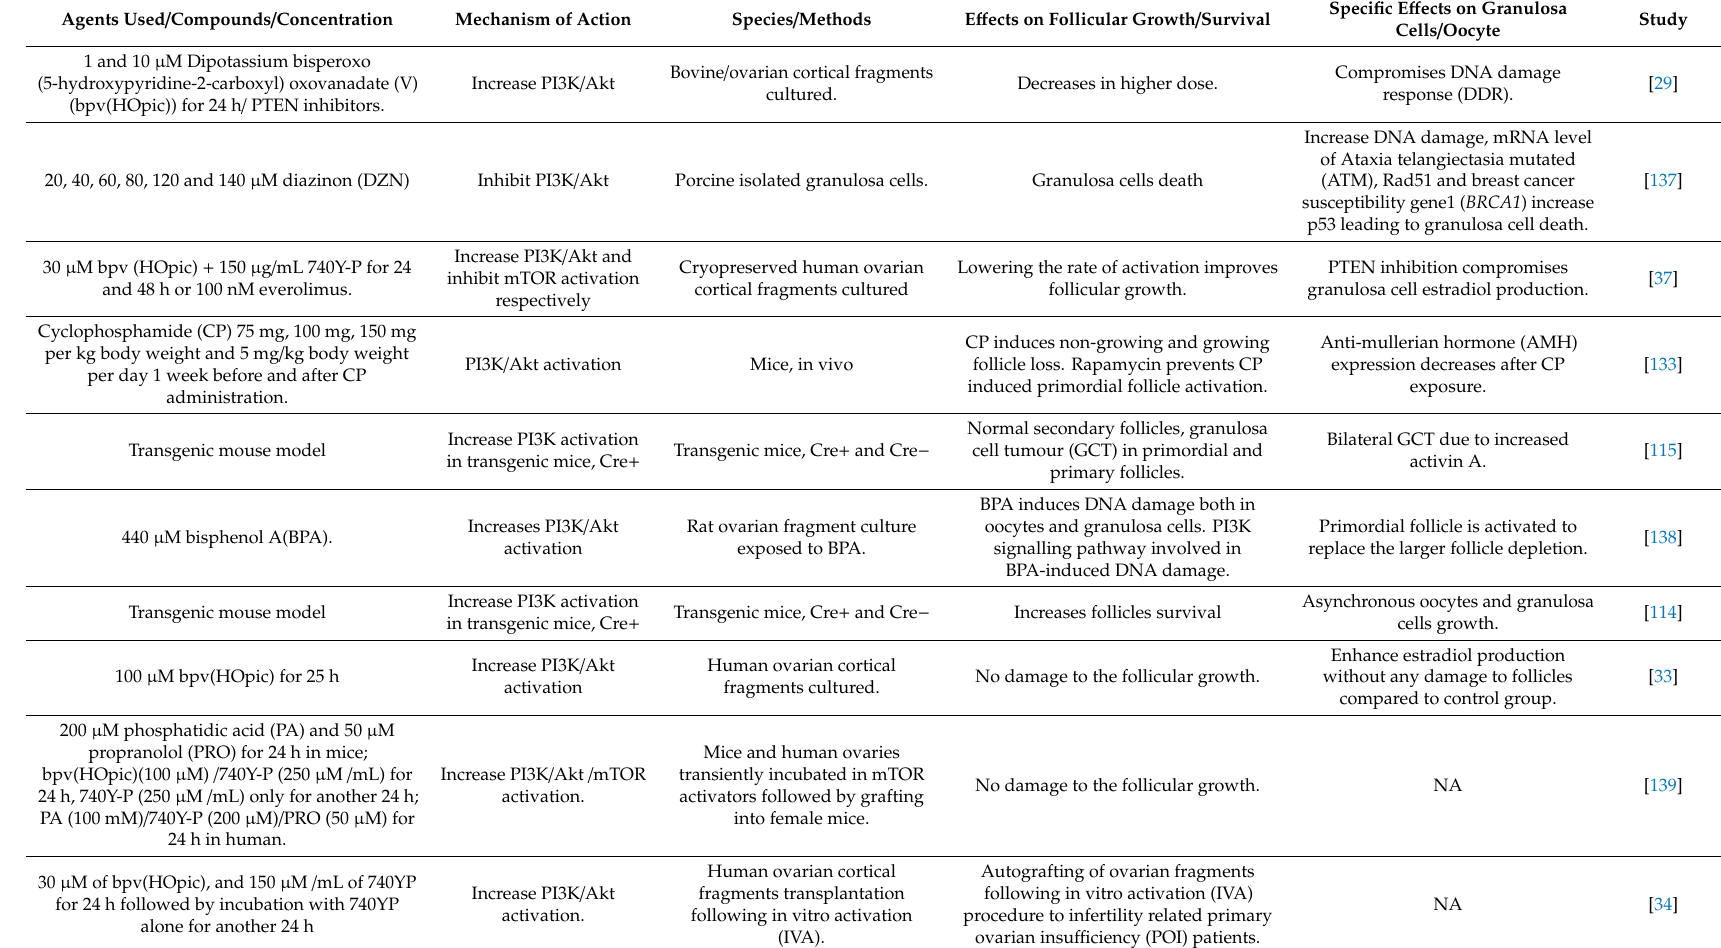
Table 1. Recent studies investigating the impact of phosphatase and tensin homolog deleted on chromosome 10 / phosphoinositide 3-kinase / protein kinase B / mammalian target of rapamycin complex (PTEN / PI3K / Akt / mTORC) pathway either as a part of genetic modification / pharmacological activation, chemotherapy treatment or ovotoxicity exposure on primordial follicle activation, follicular growth and